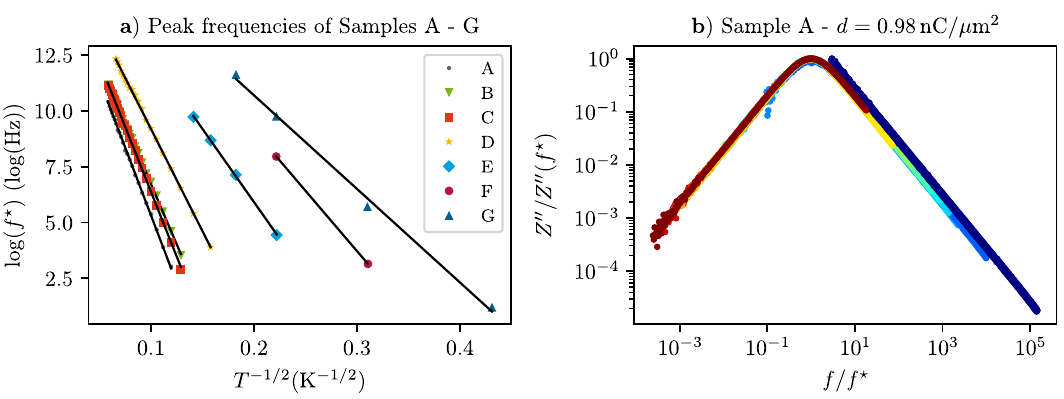
Figure 2. Frequency-dependence of real (resistance) and imaginary part (reactance) of impedance of selected Pt/C samples. ( a ) Real part and ( c ) imaginary part of impedance Z for sample A vs. frequency for various temperatures as indicated by the color code given in the legend. ( b ) Real and ( d ) imaginary part of Z for sample G.